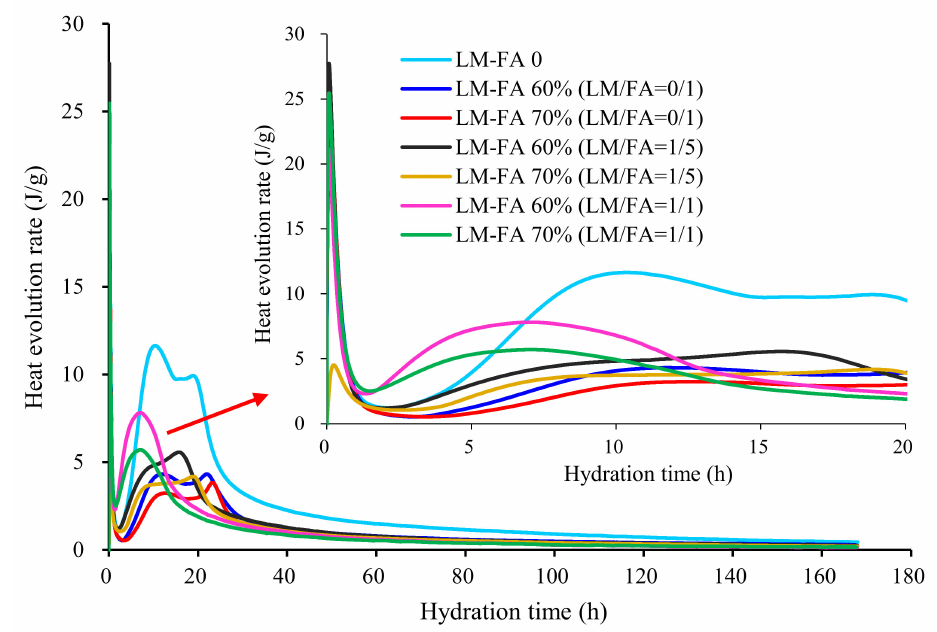
Figure 12. Influence of LM and FA on thermal power of mixtures.